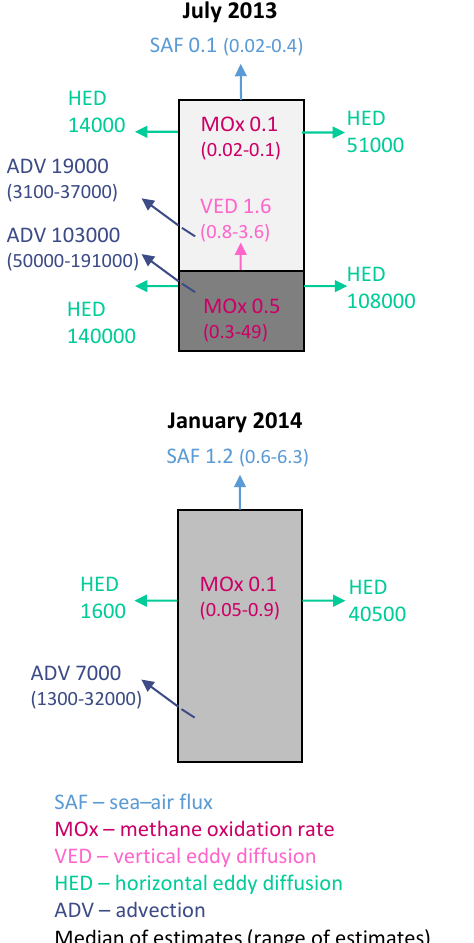
Figure 8. Sketch of transport and loss terms estimated for the study area in nmolm − 2 s − 1